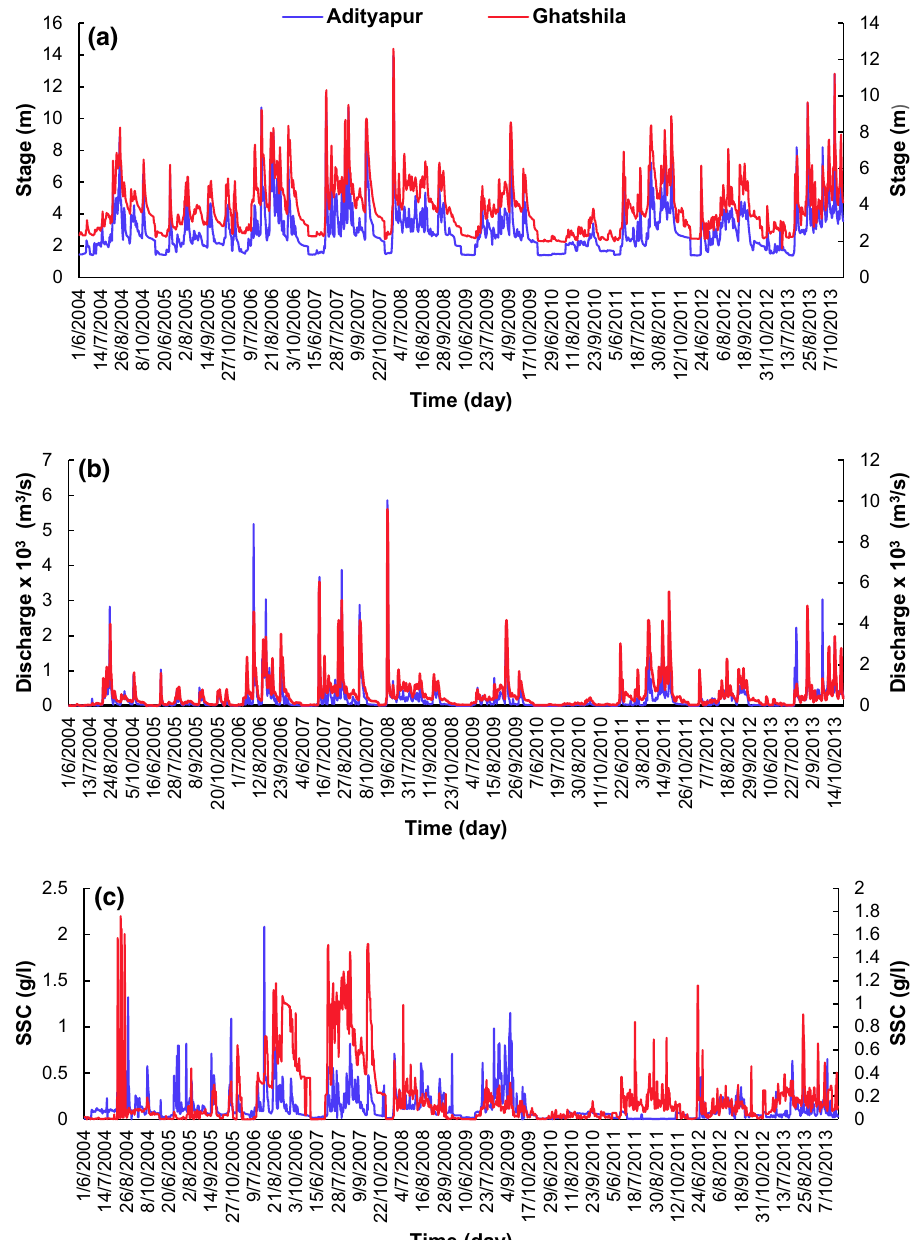
Fig. 2 Time-series representa- tion: a stage, b discharge